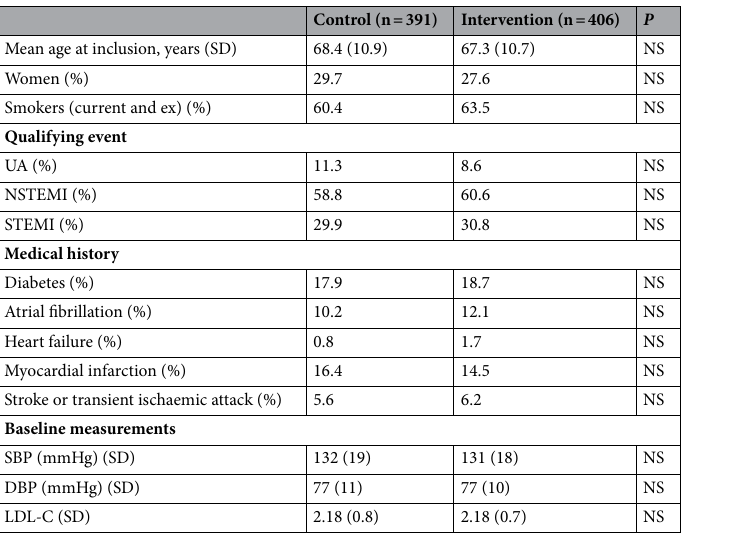
Table 1. Baseline characteristics of the randomised study population at 36 months. NS not significant, SD standard